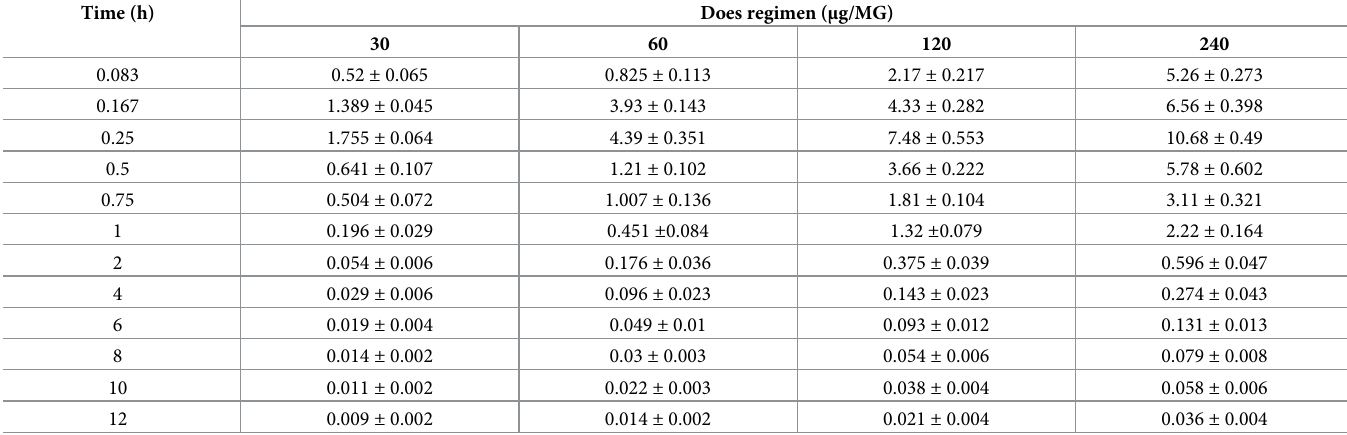
Table 1. The cefquinome concentration ( μ g/mL) in the plasma of mice with Streptococcus agalactiae- induced mastitis following intramammary administration of 30, 60, 120, 240 μ g/MG.